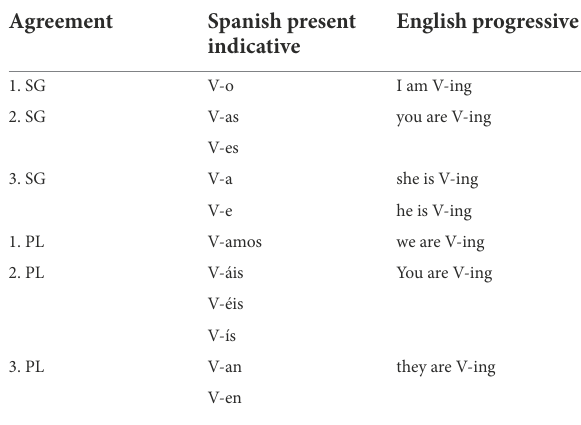
TABLE 1B Possible syntactic paradigms for the analyses of productivity across Spanish and English (V means verb).